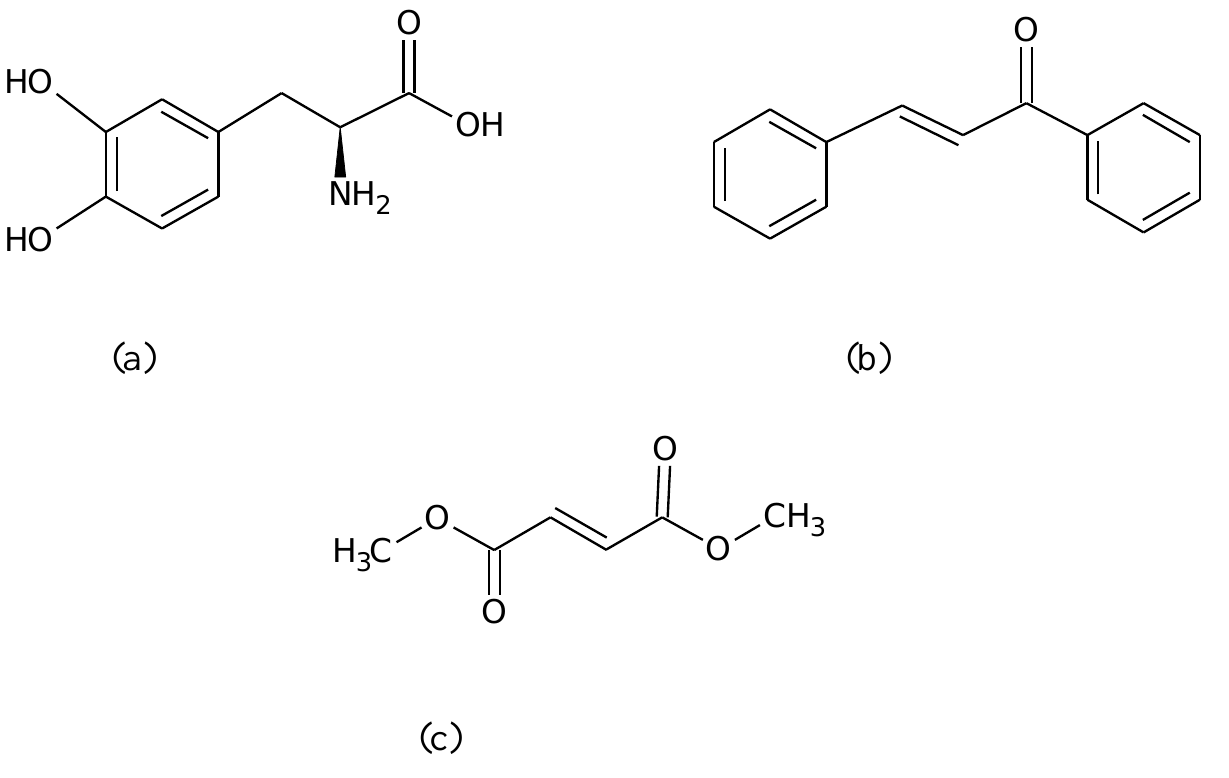
Figure 7. Chemical formula of ( a ) L-dopa, ( b ) chalcone, and ( c ) dimethyl fumarate. Chalcones with a common chemical scaffold of 1,3-diaryl-2- propen-1-one, are richly existent in nature with a wide variety of pharmacological activities. Chalcone-type com- pounds (Figure 7b) stimulate Nrf2 by modifying the cysteine residues of Keap1 by Michael addition since they contain an α , β -unsaturated carbonyl group. The Nrf2 activator com- pounds that contain an α , β -unsaturated carbonyl group display powerful antioxidant and anti-inflammatory effects